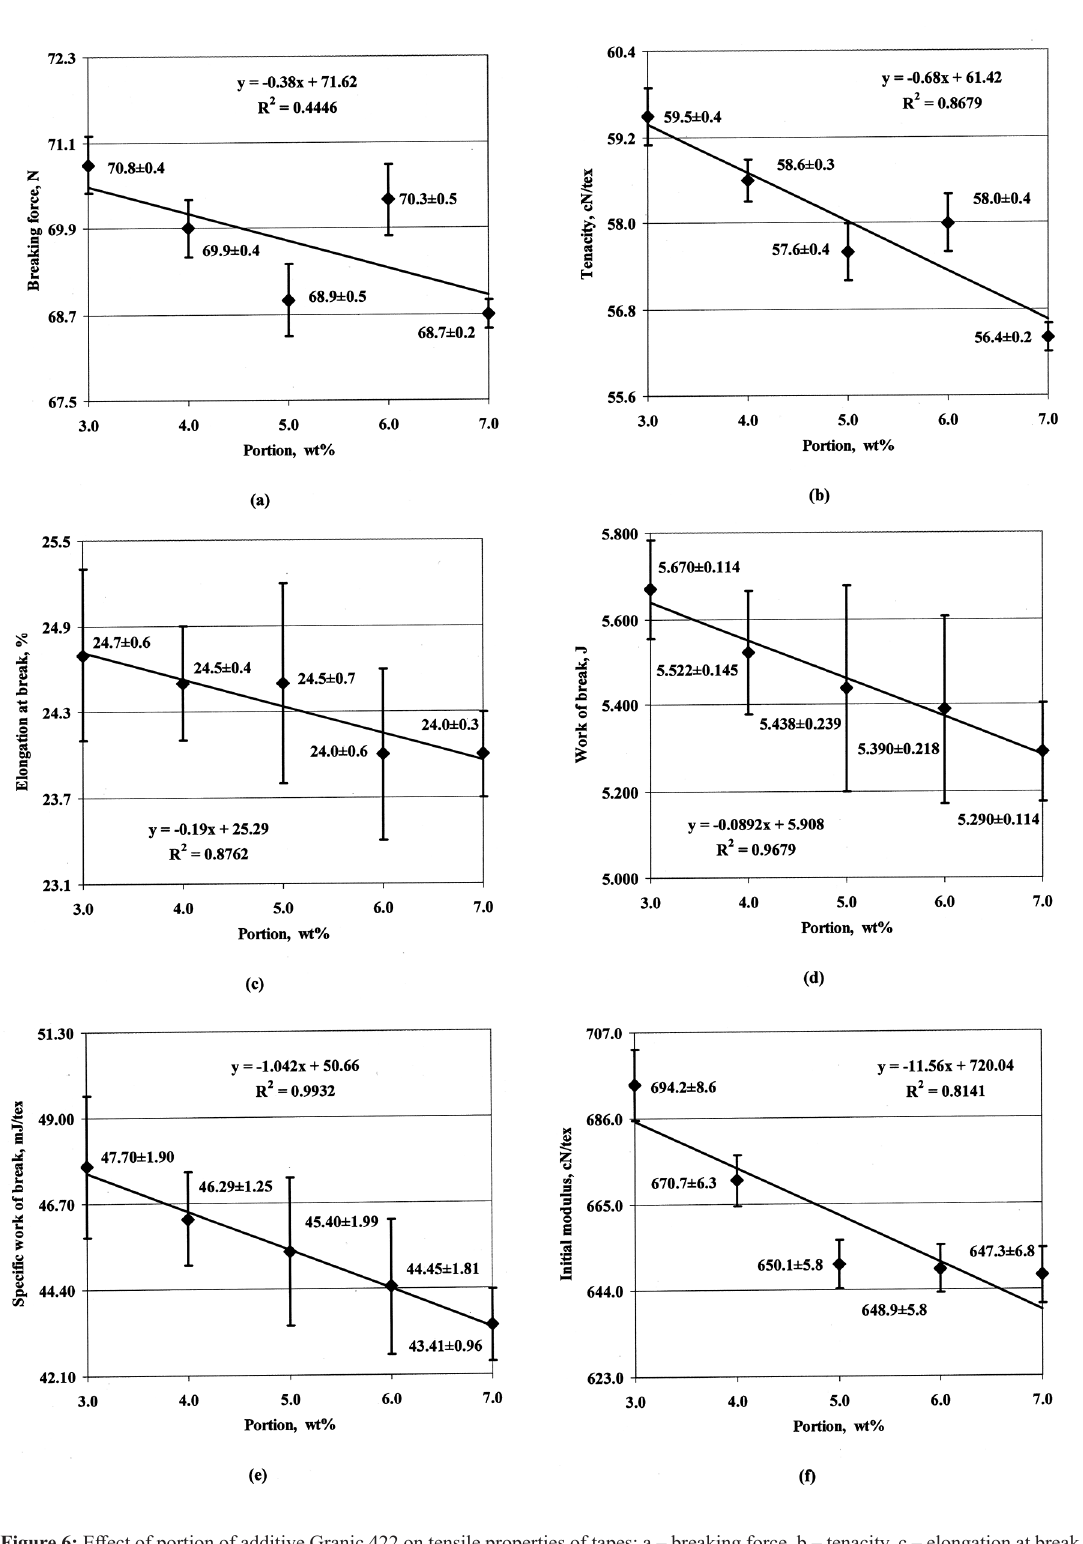
Figure 6: Effect of portion of additive Granic 422 on tensile properties of tapes: a – breaking force, b – tenacity, c – elongation at break, d – work of break, e – specific work of break, f – initial